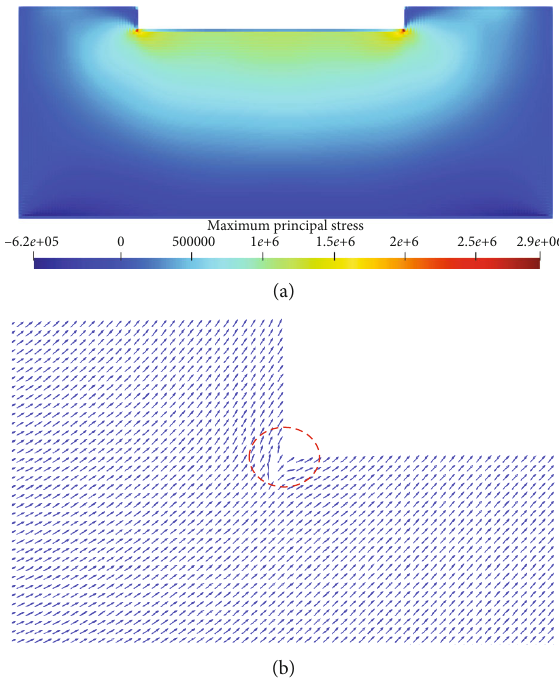
Figure 12: Distributions of maximum principal stress and the particle velocity. (a) Distributions of maximum principal stress. (b) Distributions of particle